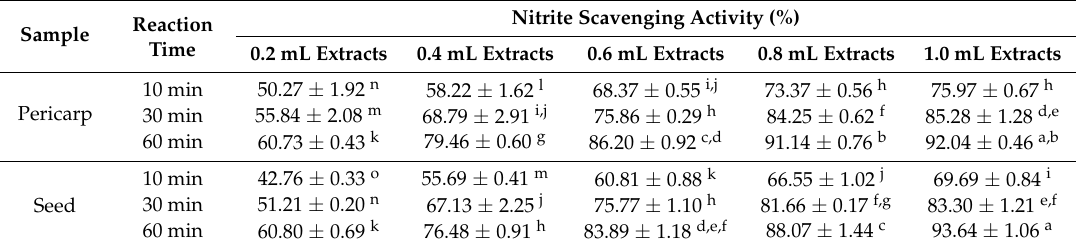
Table 5. Nitrite scavenging activities of flavonoid extracts from longan byproducts.